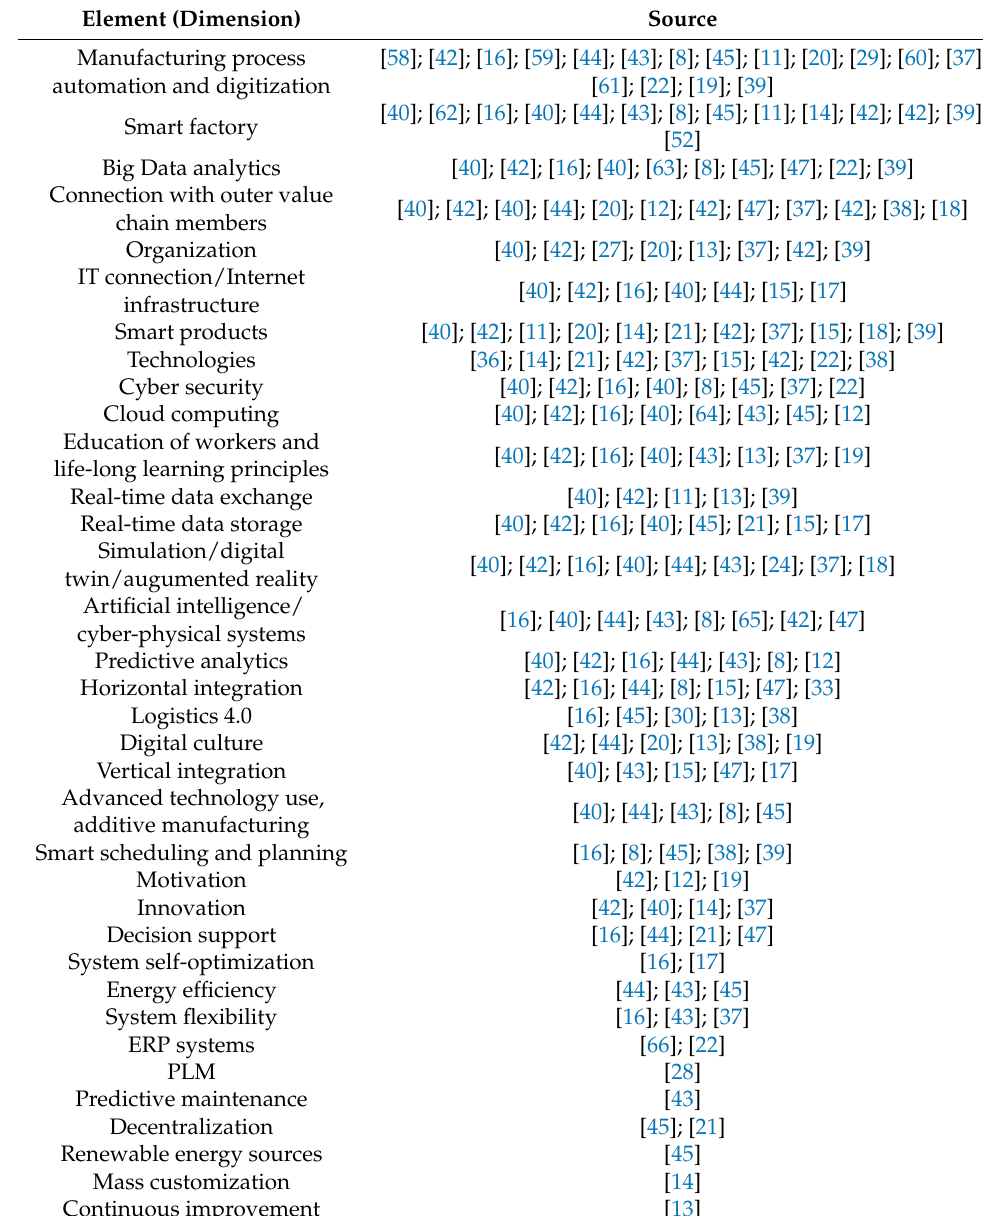
Table 2. Most common elements of Industry 4.0 in